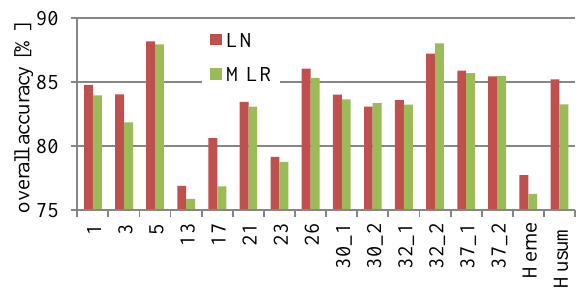
Figure 5. Overall accuracy [%] achieved for all test sites for two versions LN and MLR. Except for Herne and Husum, the numbers are the patch numbers of the Vaihingen data (Wegner et al., 2015).